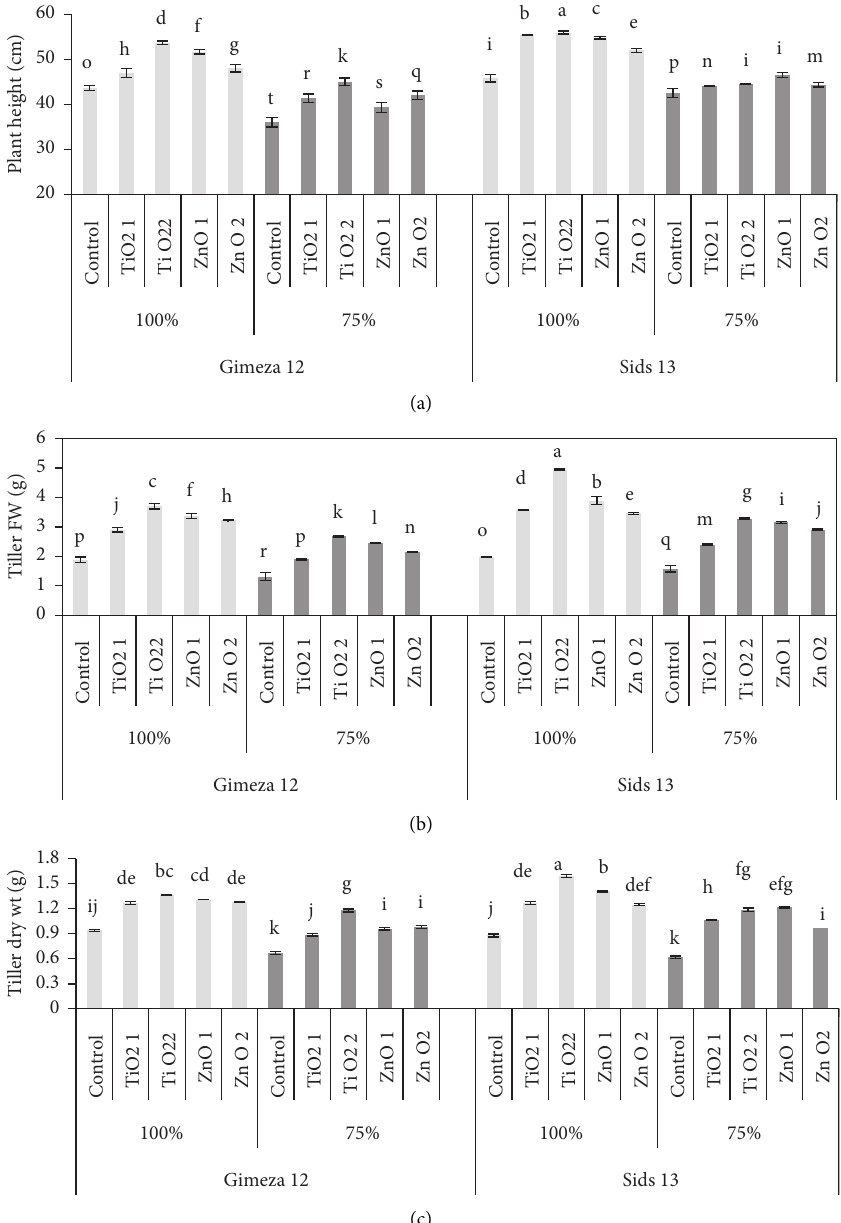
Figure 2: Effect of different concentrations of nano-TiO 2 or nano-ZnO (5 and10 mg/L) on plant height (a), tiller fresh weight (b), and tiller dry weight (c) at 75 days from sowing of both wheat cultivars (Gimeza 12 and Sids 13) subjected to different levels of water irrigation requirement (combined analysis of two seasons). TiO 2 1 � 5mg/L, TiO 2 2 � 10mg/L, ZnO 1 � 5mg/L, and ZnO 2 �